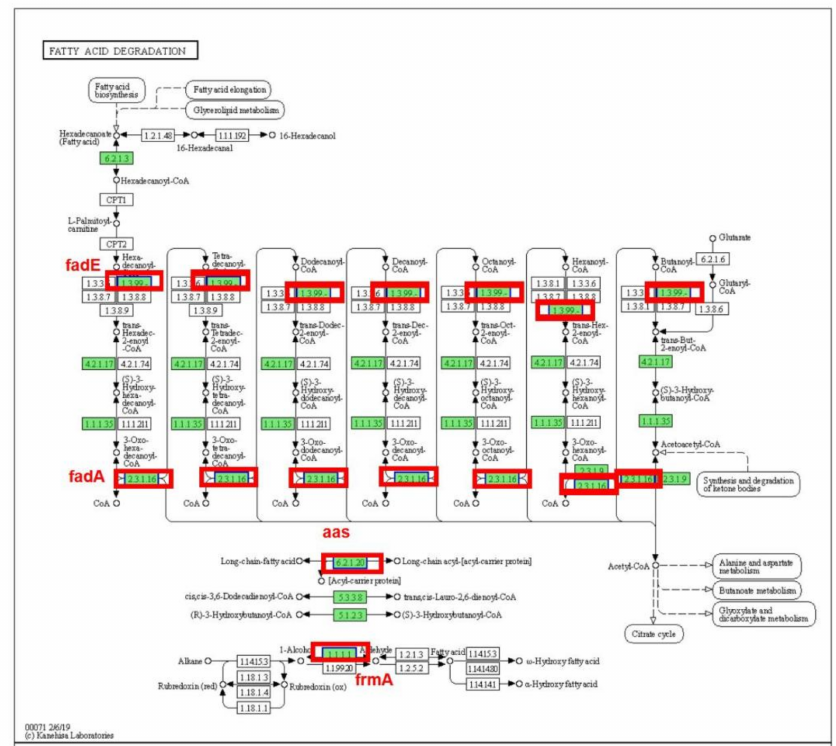
Figure 4. Fatty acid degradation pathway of E. coli ; Green indicates down-regulation > 0.83 times; and red shows down-regulation <